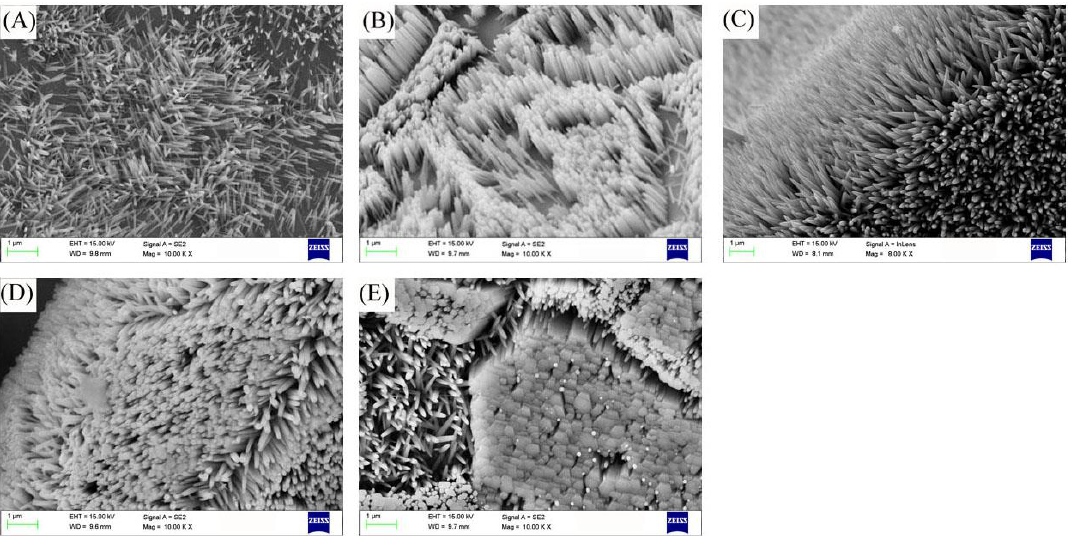
Figure 1. Scanning electron microscopy (SEM) image of ZnO at different solution concentrations: ( A ) 20 mmol/L, ( B ) 30 mmol/L, ( C ) 40 mmol/L, ( D ) 50 mmol/L, and ( E ) 60 mmol/L.